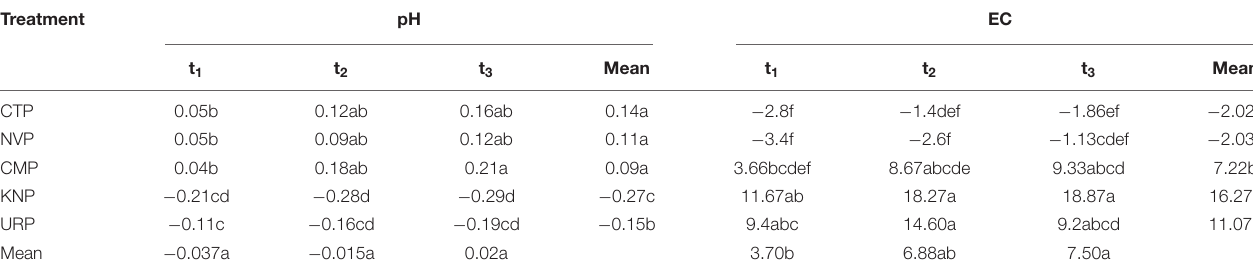
FIGURE 2 | Mean values with standard error bar of soil pH in soil profile (0–100 cm) for the treatments NVP, CTP, CMP, KNP, and URP before (t 0 ) and after fertilization at t TABLE 1 | The results of two-way ANOVA (split plot design) was used with the Tukey HSD ( α = 0.05).